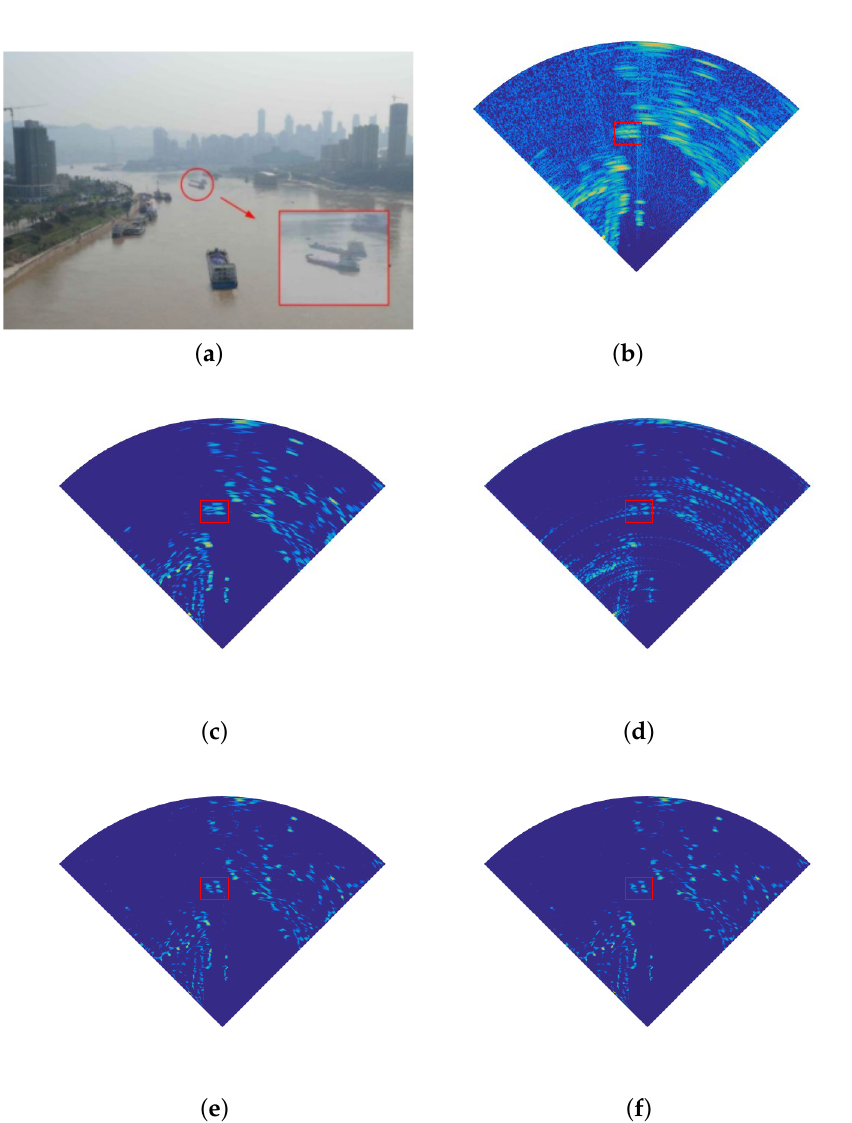
Figure 4. Real data processing results with different methods. ( a ) Optical scenario. ( b ) RBM raw echo. ( c ) The processing result using the REGU method. ( d ) The processing result using the TSVD method. ( e ) The processing result using the PML method. ( f ) The processing result using the IPML